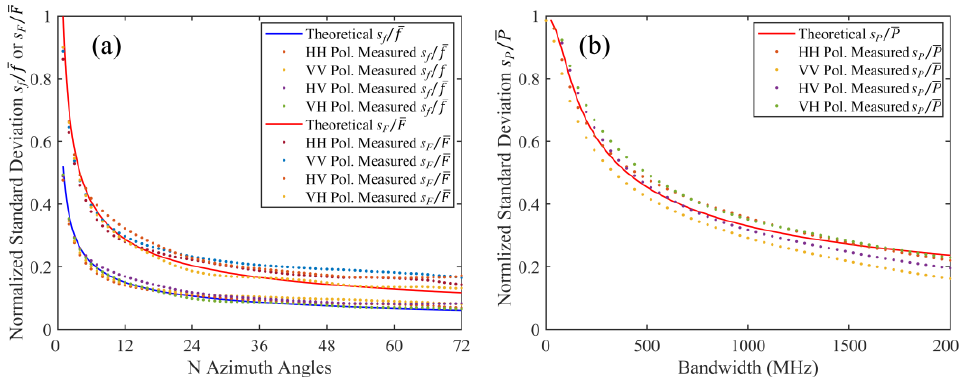
Figure 15. Comparisons between measured and theoretical normalized standard deviations after ( a ) spatial and ( b ) frequency averaging. ( a ) spatial and ( b ) frequency